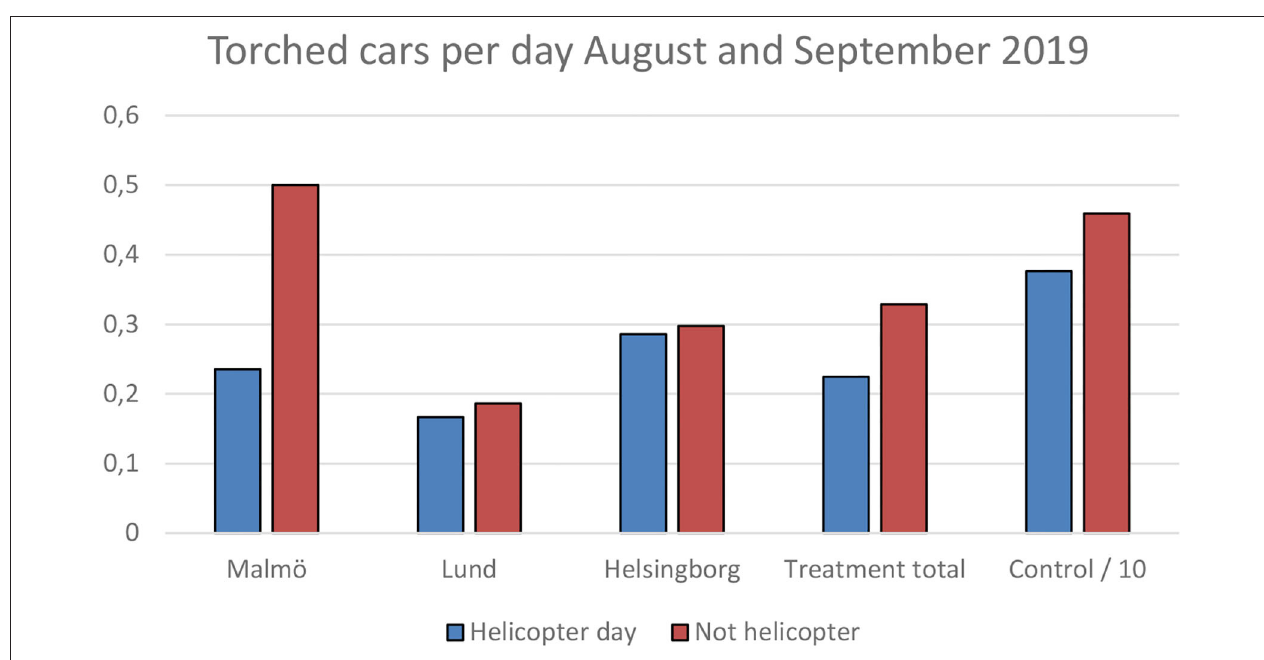
FIGURE 6 | Vehicle arsons per day during the treatment time period in treatment and control